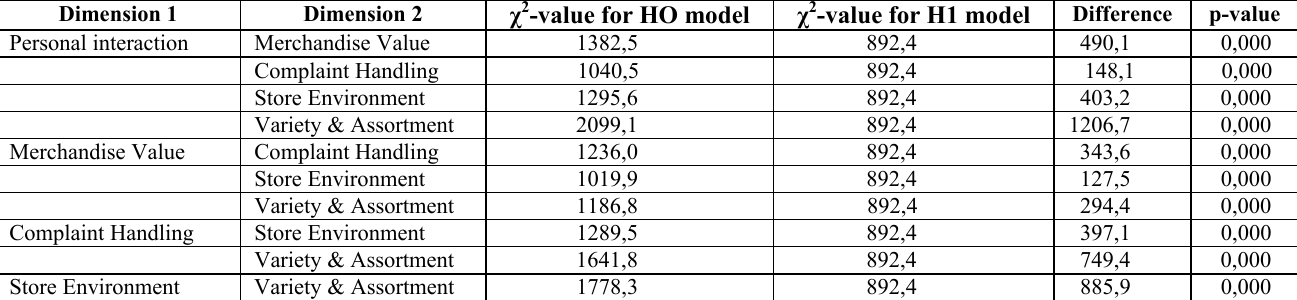
Table 14: Discriminant validity between individual dimensions: Sample 2 Dimension